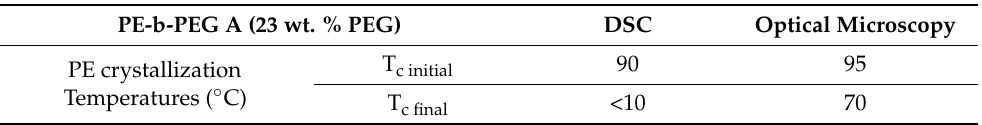
Table 5. Comparison of melting and crystallization temperatures of PE and PEG blocks for PE-b-PEG A obtained by optical microscopy and DSC.